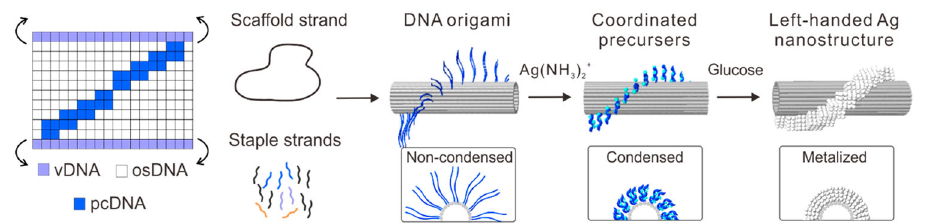
Fig. 1 Site-selective nucleation of silver nanoparticles on native DNA. Incorporation of pcDNA sites into a DNA origami template allows for site-selective nucleation of silver-amine complexes in solution, yielding 3D chiral inorganic structures after reduction with glucose. Reprinted with permission from Zhang et al. 1 . Copyright 2021 American Chemical